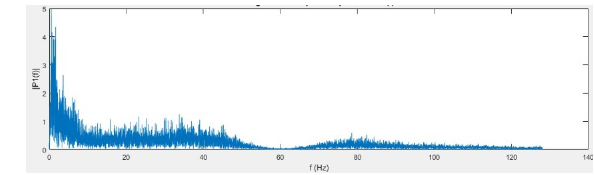
Figure 2. FFT of Input Signal